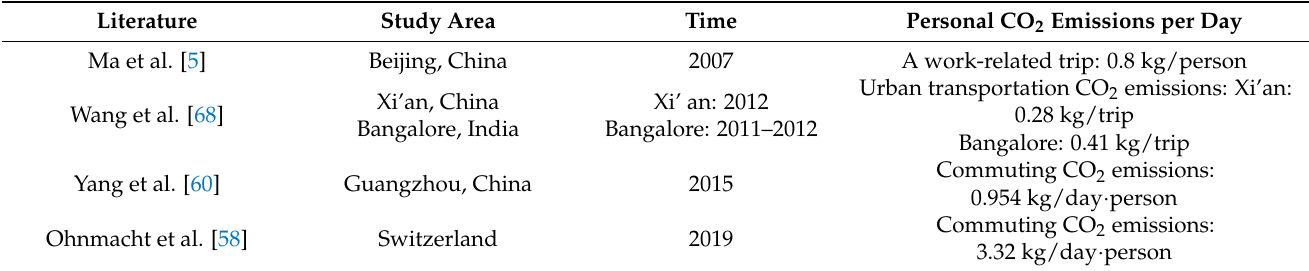
Table 8. Individual travel CO 2 emissions in different